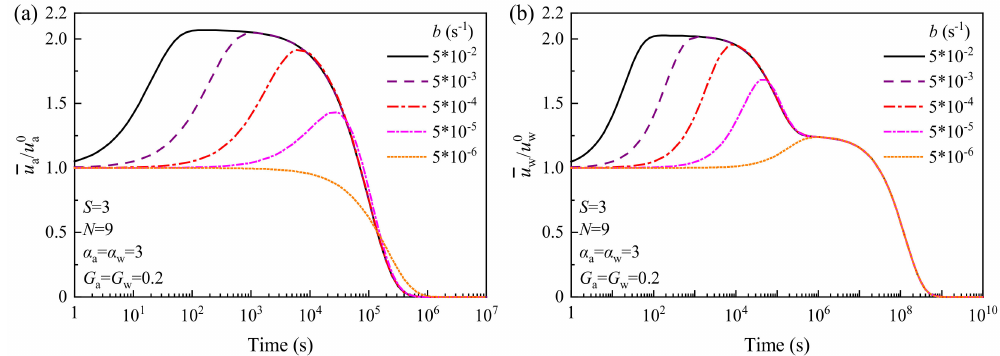
Figure 4. Dissipation of ( a ) excess pore-air and ( b ) pore-water pressures against various exponential loading parameters, b